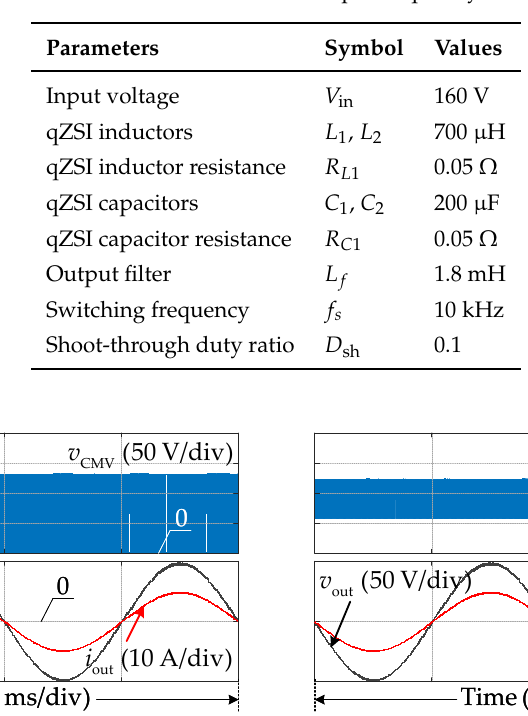
Table 2. Parameters of the three-phase qZSI system.